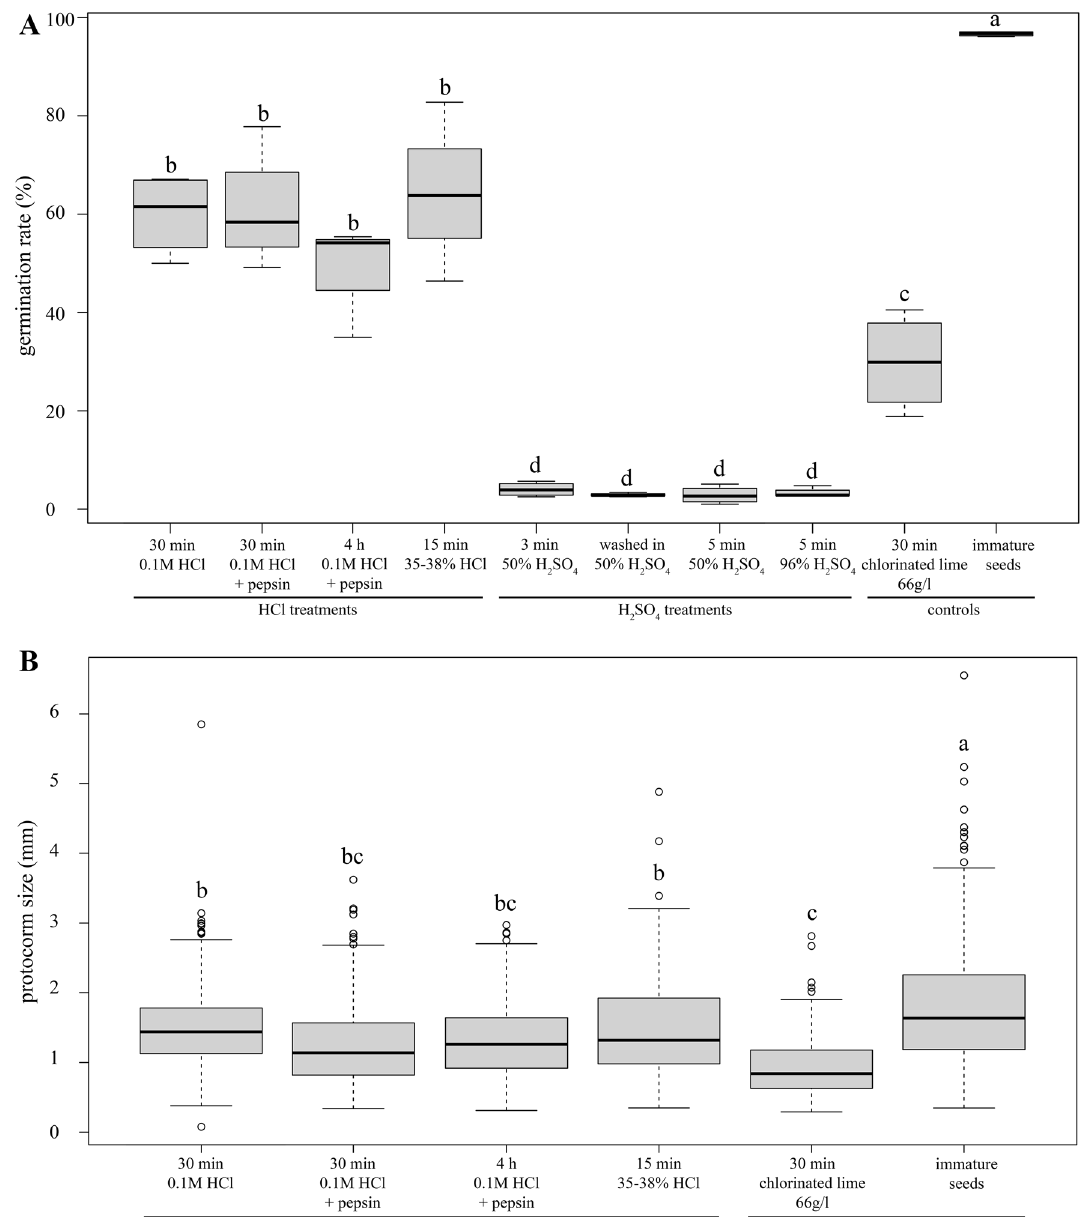
Fig. 1 Germination percentage ( A ) and protocorm size ( B ) of Vanilla planifolia after different treatments of seeds measured 5 months after sowing. Immature seeds excerpted from surface sterilized unripe pods served as a positive control as they lack dormancy. Mature seeds treated with chlorinated lime represent conventional treatment published before. The cultures were incubated asymbiotically on medium BM1 at 30 °C in dark. Pepsin was used in concentration 0.5 g/100 ml. Different letters indicate significantly different groups of data according to the result of post-hoc multiple comparison test (α 0.05). Boxplots compose of whiskers (minimum and maximum), edges of the box (lower and upper quartiles), = dividing line (median) and points (outliers). Number of measured objects and other statistics can be found in Additional file 2: Table S1. Only those experimental variants that yielded a reasonable number of protocorms are included in ( B